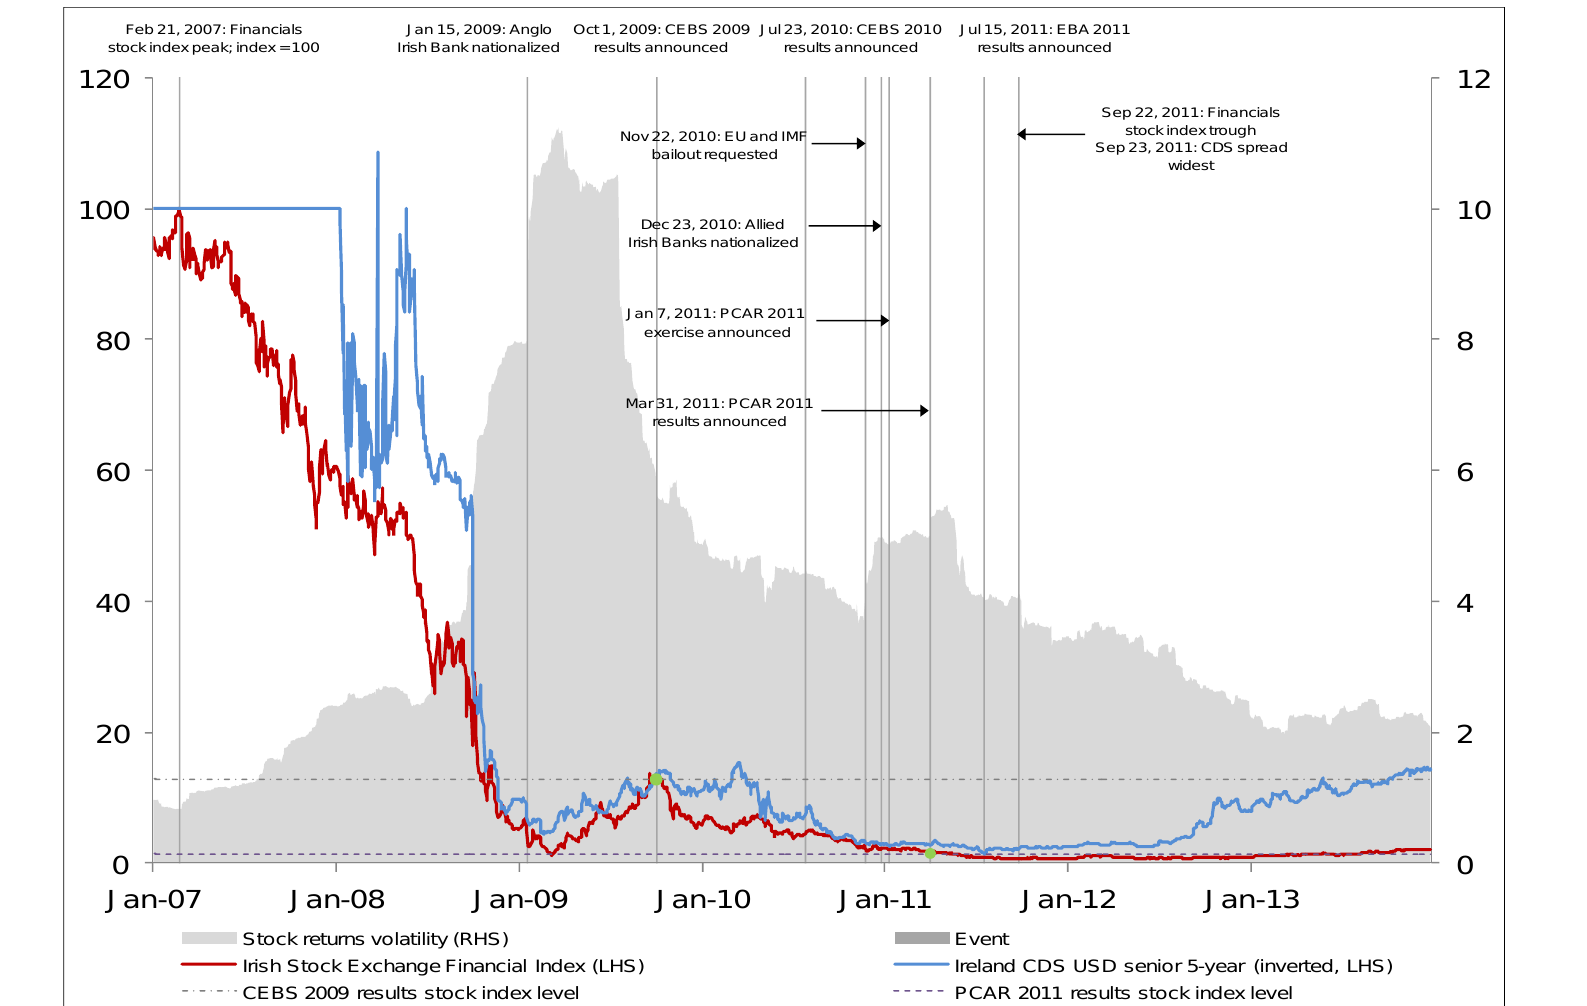
Figure 4. Ireland: The Pain before the PCAR (Indexed to 100 on 21 February